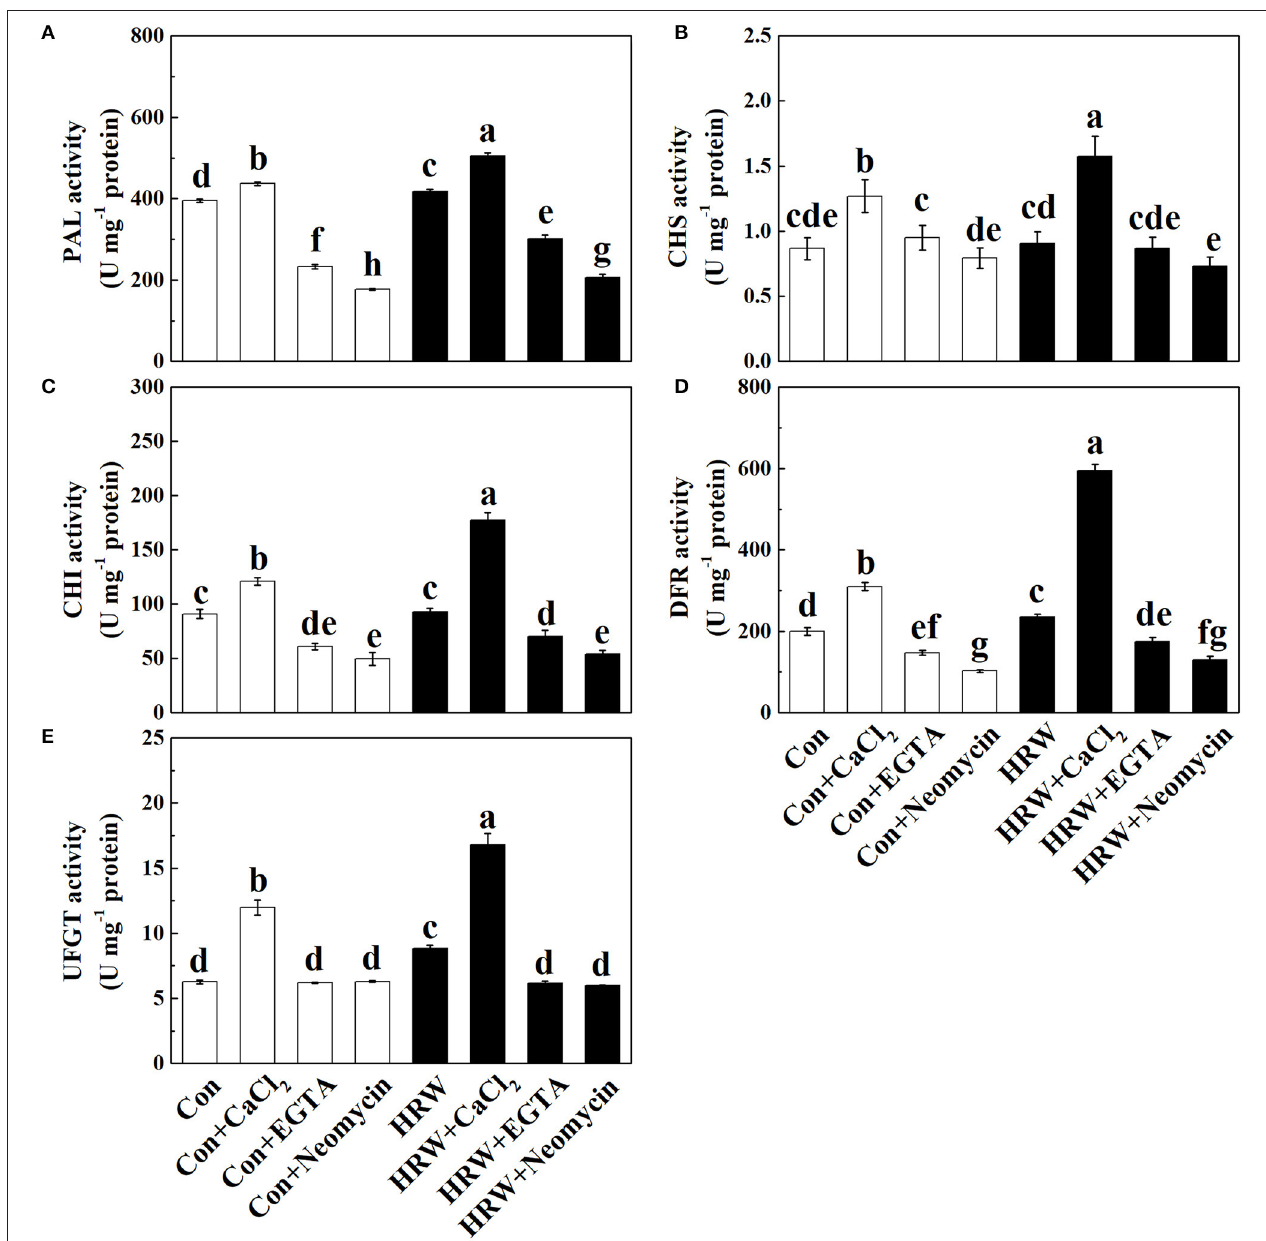
FIGURE 4 | Effects of HRW, CaCl 2 and Ca 2 + antagonists on activity of anthocyanin biosynthesis-related enzymes in radish sprouts hypocotyls under UV-A irradiation. Radish sprouts were further incubated in distilled water or HRW (100% saturation) containing 10mM CaCl 2 , 1mM EGTA or 1mM Neomycin under UV-A irradiation. The sample with distilled water alone was the control (Con). The activity of PAL (A) , CHS (B) , CHI (C) , DFR (D) and UFGT (E) were measured at 24h plant growth under UV-A. Data are presented as means ± SE ( n = 3). Bars with different letters are significantly different at P < 0.05 according to Duncan’s multiple test.